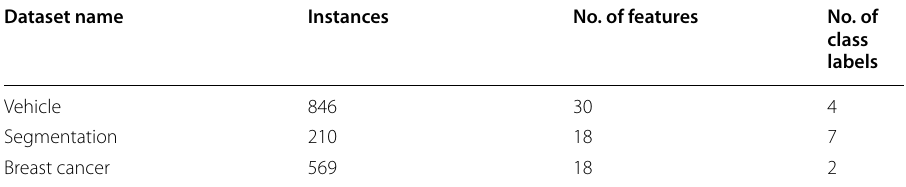
Table 2 Description of the datasets used for the classification task Dataset